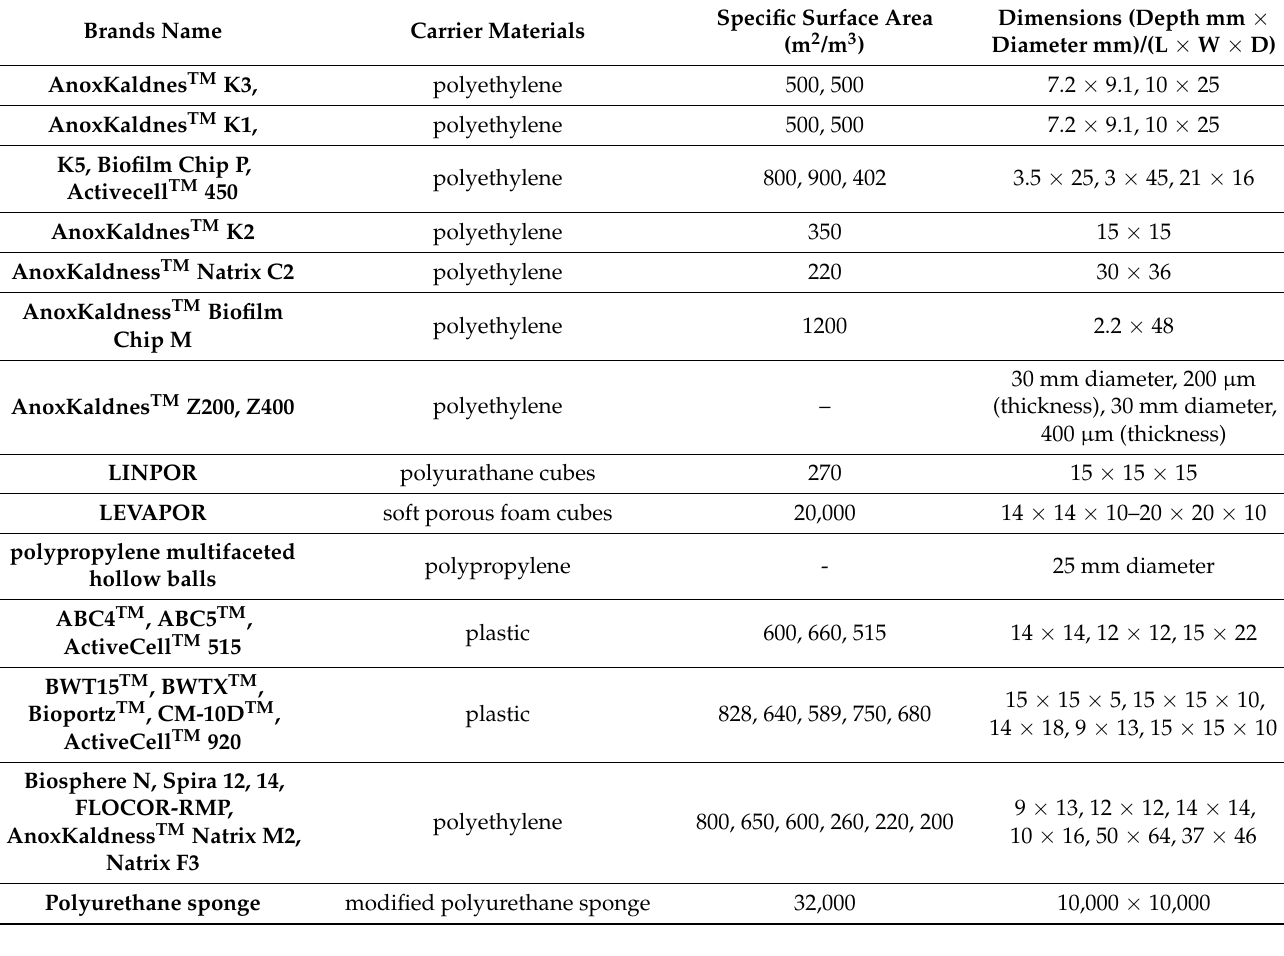
Table 2. Popular carriers and their characteristics [59].